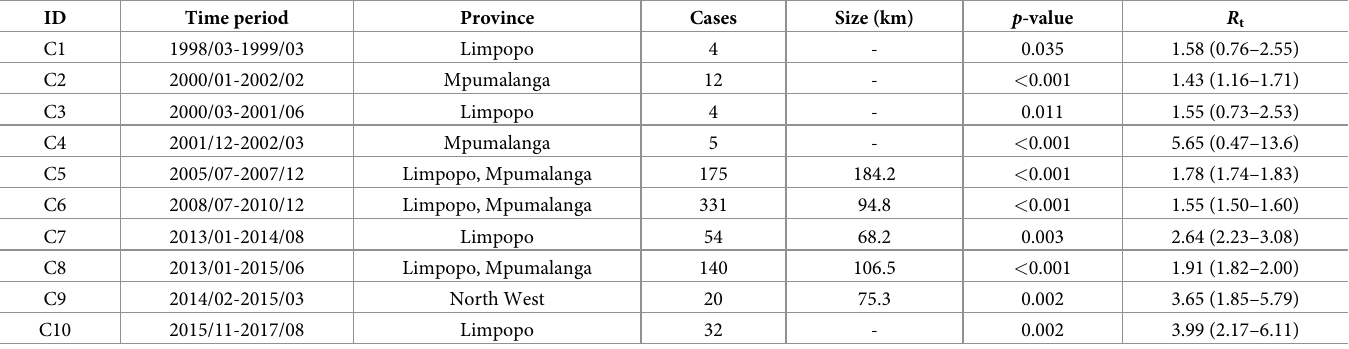
Table 2. Time period, province, number of dog rabies cases, and size of the spatio-temporal clusters in South Africa and their reproduction number ( R t ).